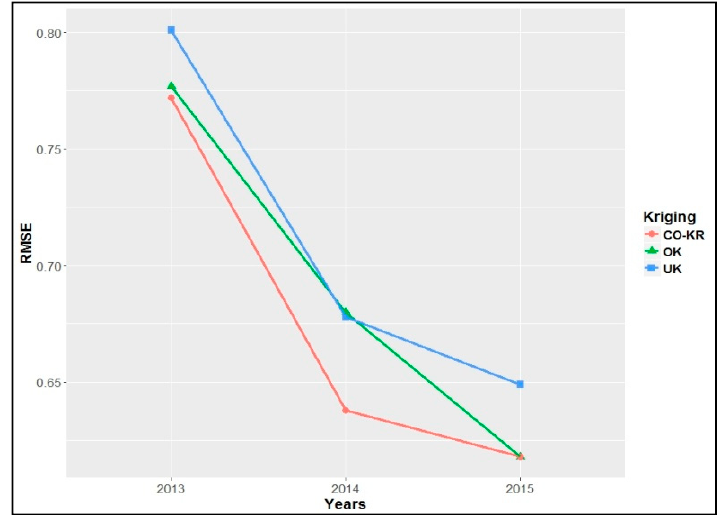
Figure 10. Root mean square error (RMSE) of the predictions between the training set and the test set for each year for ln(Fe).